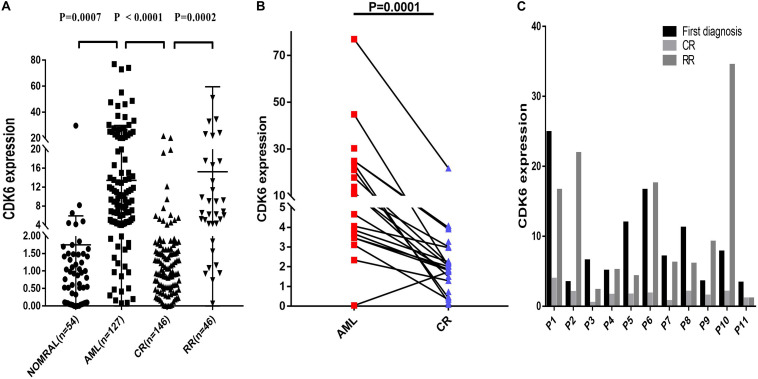
Relative levels of CDK6 expression in the validated non-APL AML patients. (A) The CDK6 expression in healthy donors (n = 54), de novo non-APL patients (n = 127), AML-CR patients (n = 146), and AML-RR (n = 48) patients from Xiangya Hospital and The First Affiliated Hospital of Jinan University Hospital. The distributions of CDK6 expression were presented with scatter plots. The expression level of CDK6 mRNA in de novo non-APL AML patients (n = 127) compared with the normal samples (n = 54) (mean ± SEM level: 13.42 ± 1.46 vs. 1.75 ± 0.5703, p = 0.007). The expression level of CDK6 mRNA in de novo non-APL AML patients (n = 127) compared with AML-CR patients (n = 146) (mean ± SEM level: 13.42 ± 1.46 vs. 2.257 ± 0.2894, p < 0.0001). The expression level of CDK6 mRNA in AML-RR patients (n = 48) compared with AML-CR patients (n = 146) (mean ± SEM level: 15.11 ± 6.256 vs. 2.257 ± 0.2894, p = 0.0002). (B) The CDK6 expression at the time of diagnosis higher than at the time of evaluation for response following standard induction (3 + 7) chemotherapy in patients with AML who achieved CR (p = 0.0001) (n = paired groups of 29). (C) P1–P11 represented 11 paired AML non-APL patients with available follow-up data in first diagnosed time, complete remission (CR) and refractory remission (RR) time. (First diagnosed time vs. CR time: p = 0.002; RR vs. CR time: p = 0.0086, respectively) (p-Values were adjusted by the Holm–Sidak method. HD, healthy donor).